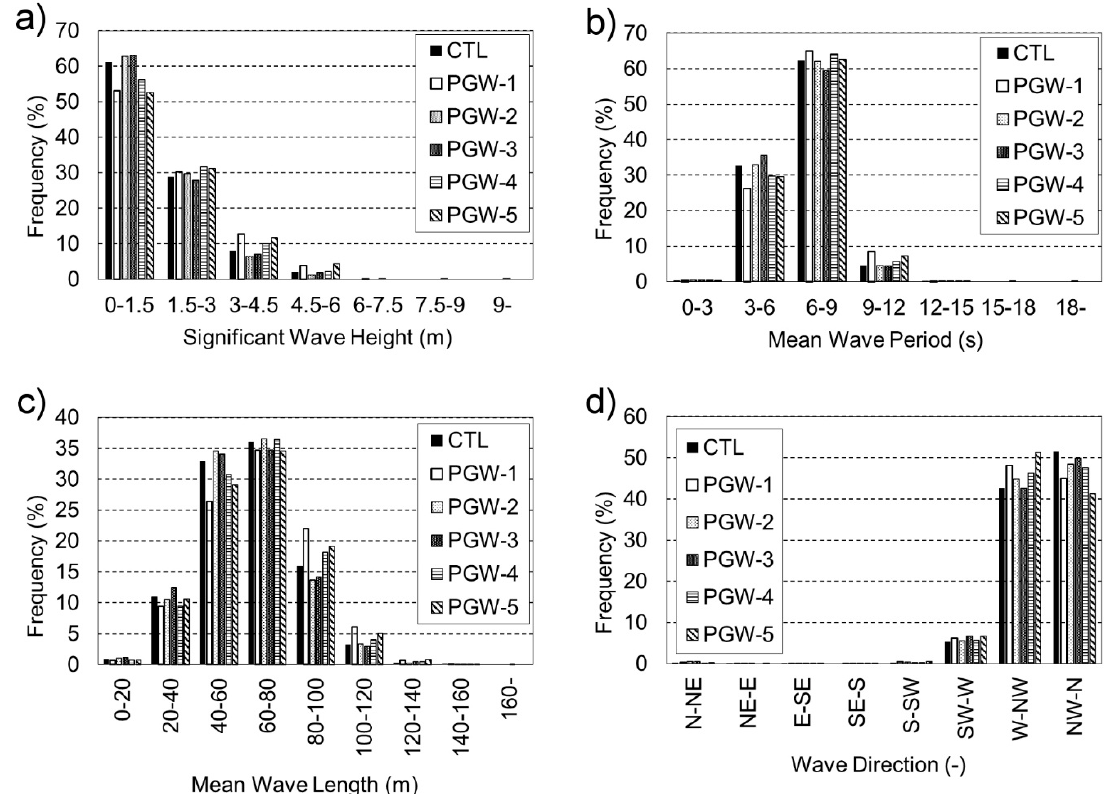
Figure 13. Frequency distribution of wave characteristics at Kanazawa. ( a ) H s , ( b ) T m , ( c ) mean wavelength, and ( d ) wave direction. Frequencies are shown in %.